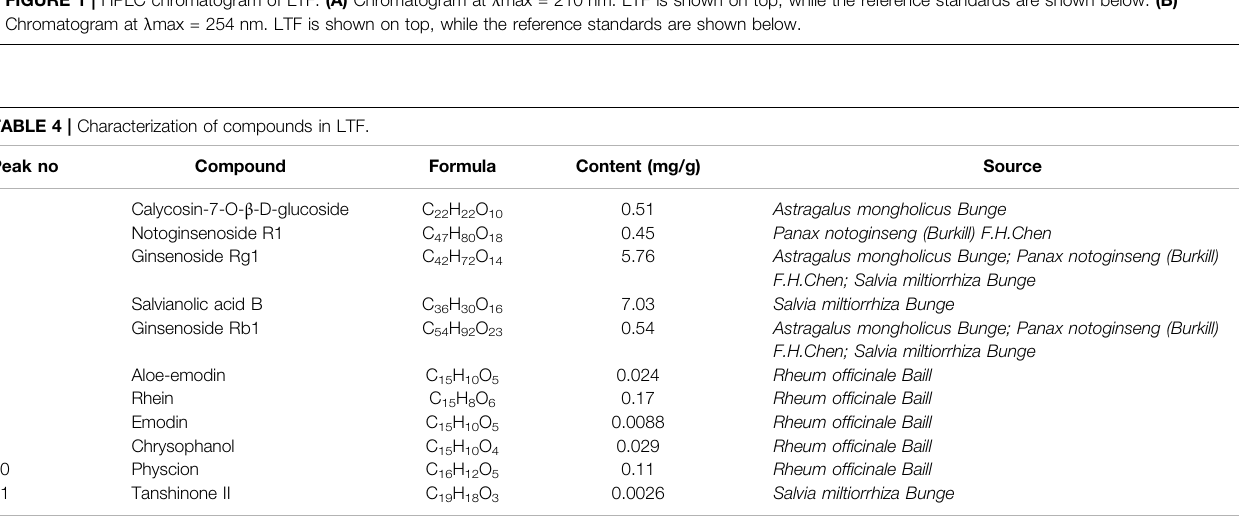
TABLE 5 | Changes in body weight and blood glucose for 0, and 12 Weeks. Parameters